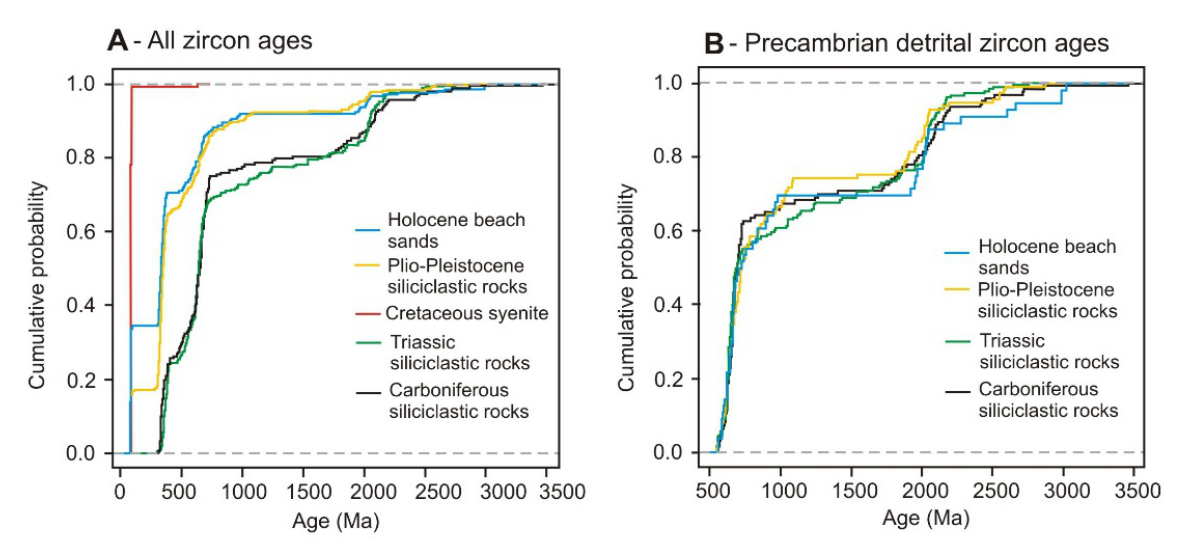
Figure 4. Cumulative age distributions of the zircon U–Pb ages from the Carboniferous (Mira Formation, South Portuguese Zone), Triassic (Silves Group, Alentejo Basin), and Pliocene-Pleistocene (Alvalade Basin) siliciclastic rocks, the Cretaceous plutonic rocks (Sines pluton), and Holocene beach sands from the Sines region. ( A ) All (detrital and magmatic) zircon ages. ( B ) Precambrian detrital zircon ages (U–Pb data compiled from